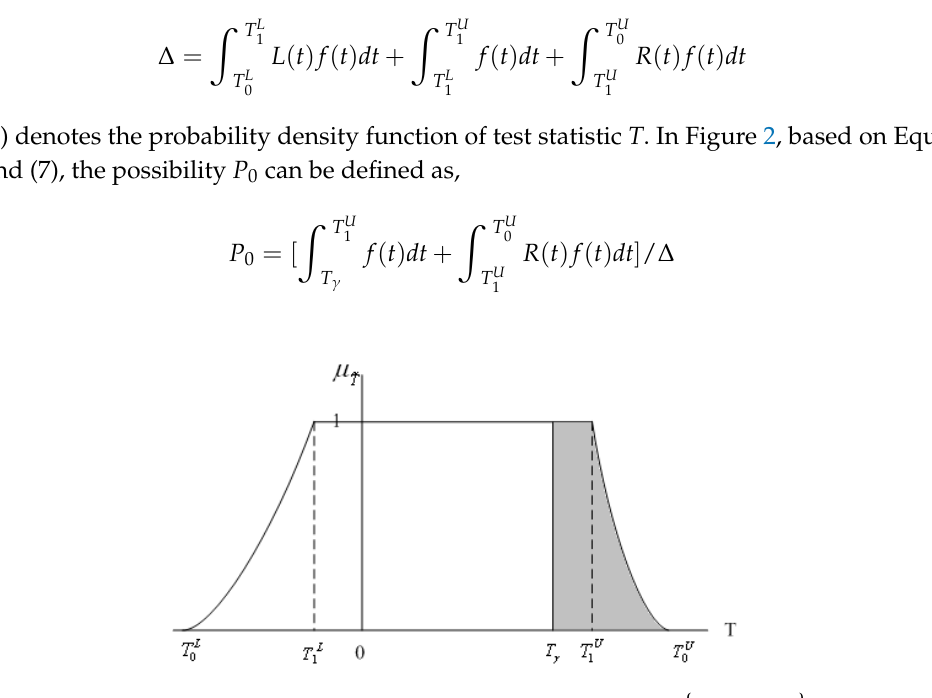
~  and rejection region } { and rejection region T (cid:101) T